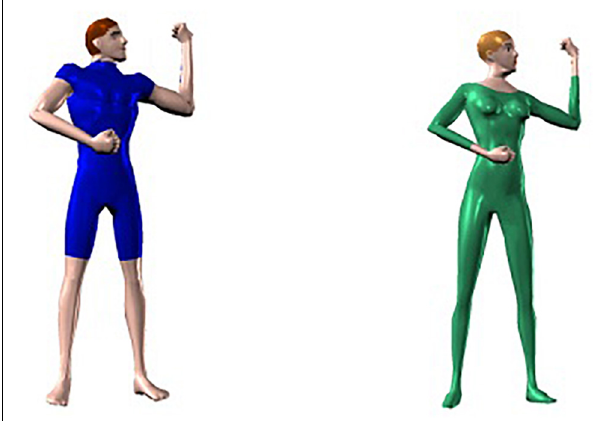
FIGURE 4 | The two actors (one male, one female) shown in Experiment